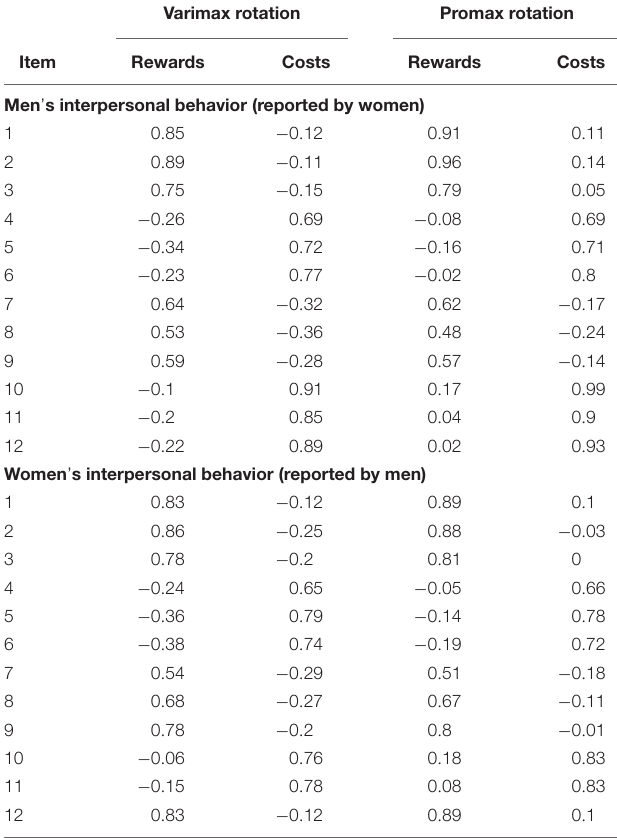
TABLE 2 | Loadings for men’s and women’s interpersonal behavior items in the pilot study ( N = 106 couples) a . Varimax